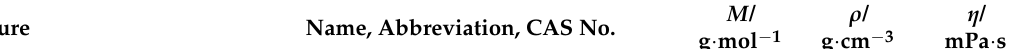
Table 13. The structures and basic information of ILs under study: molecular weight ( M ), liquid density ( ρ ), and dynamic viscosity ( η ) at temperature T = 313.15 K and pressure p = 0.1 mPa a . Structure